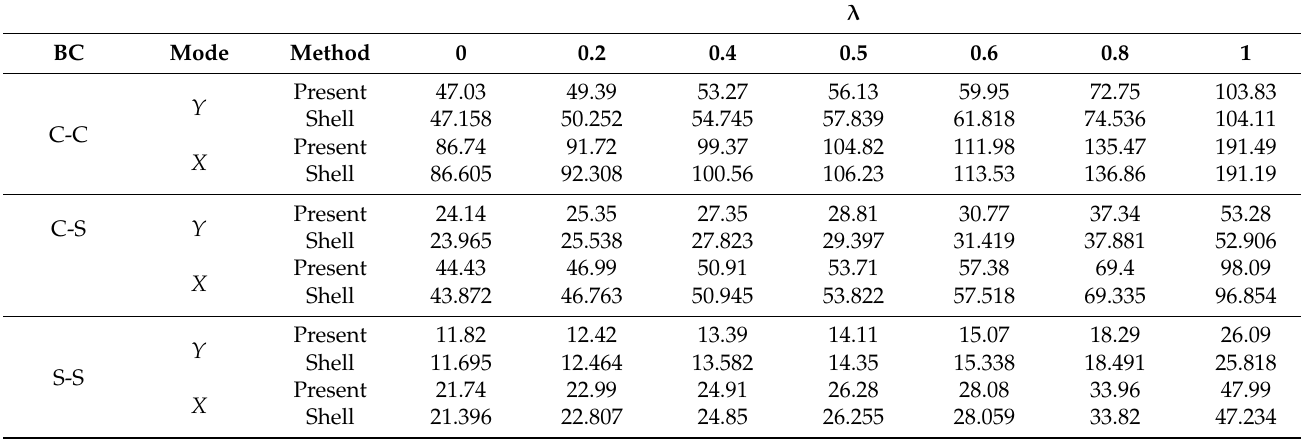
Table 4. Critical buckling temperatures of the beam L 3 = 10 m for different boundary conditions and material thickness